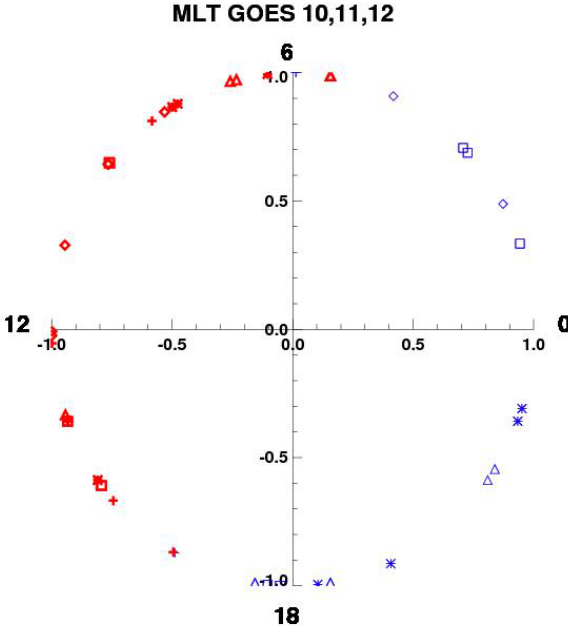
Figure 6. GOES spacecraft observations of the double-step struc- ture inMLT coordinates. The red bold marks represent double-step structure, the blue lighter marks represent observations without a double-step structure, or even any compression. The different marks represent particular GOES 8 (star), 10 (square, diamond), 11 (plus), and 12 (triangle) spacecraft.